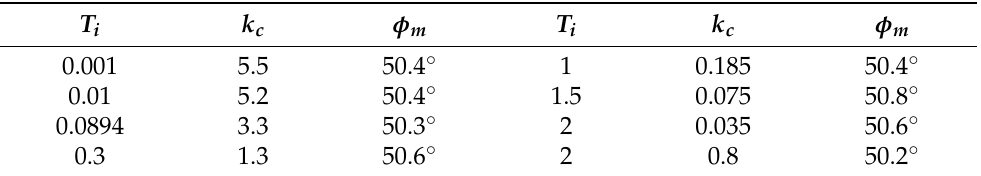
Table 2. Values of T i and k c to achieve the phase margin of φ m = 50 ◦ in a typical unit feedback closed-loop